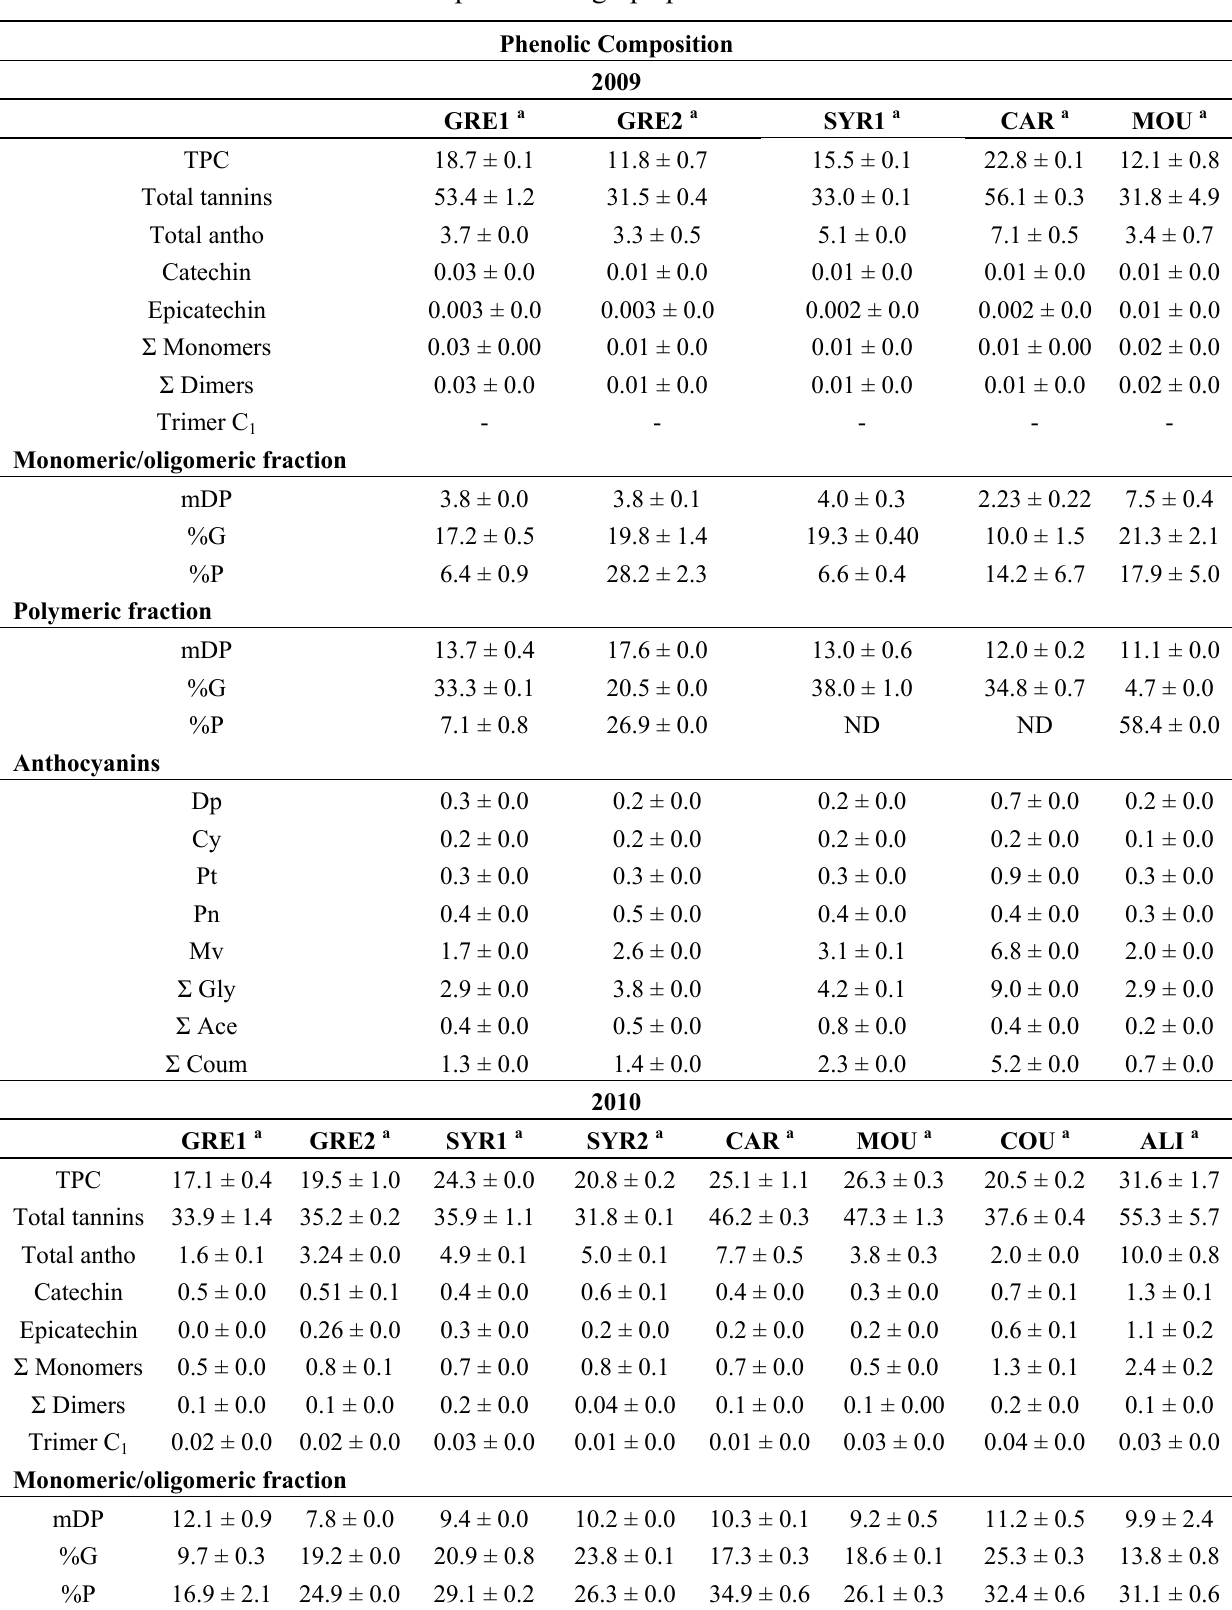
Table 4. Phenolic composition of grape pomace skins in 2009 and